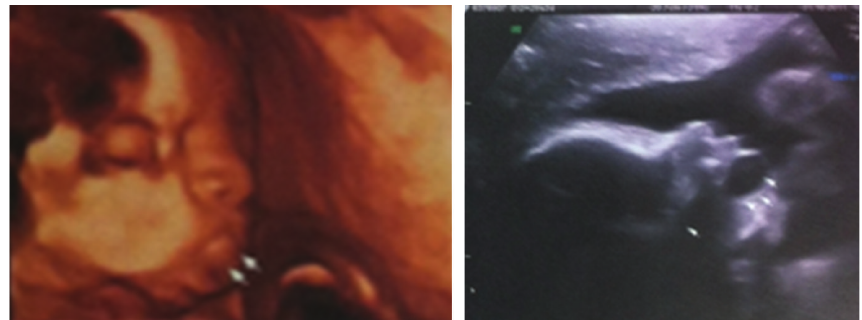
Figure 1: First examination shows an oral liquid cyst, assessed by 2D and 3D ultrasound.